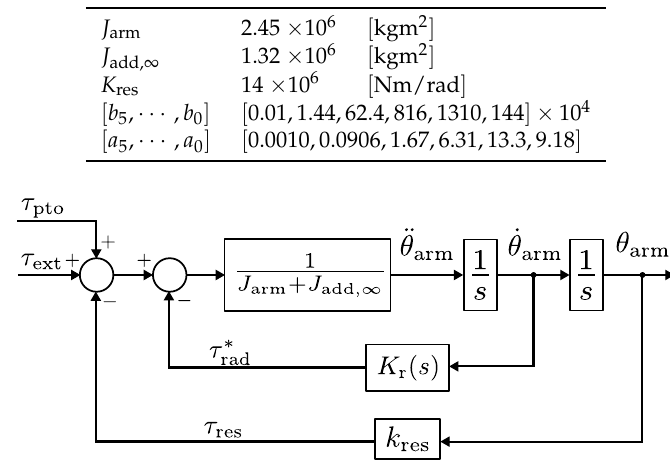
Figure 3. Block diagram of the float model.